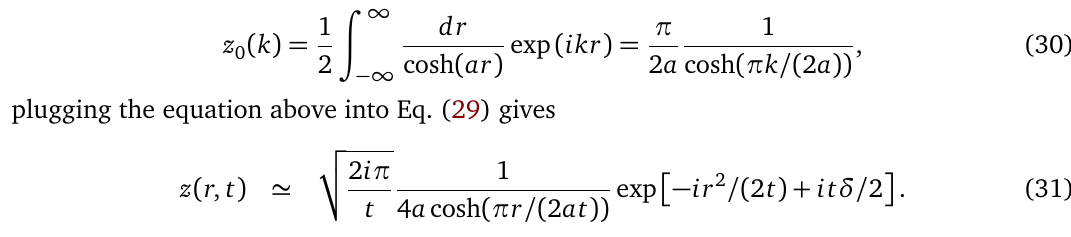
(cid:112) t (thus (cid:112) t